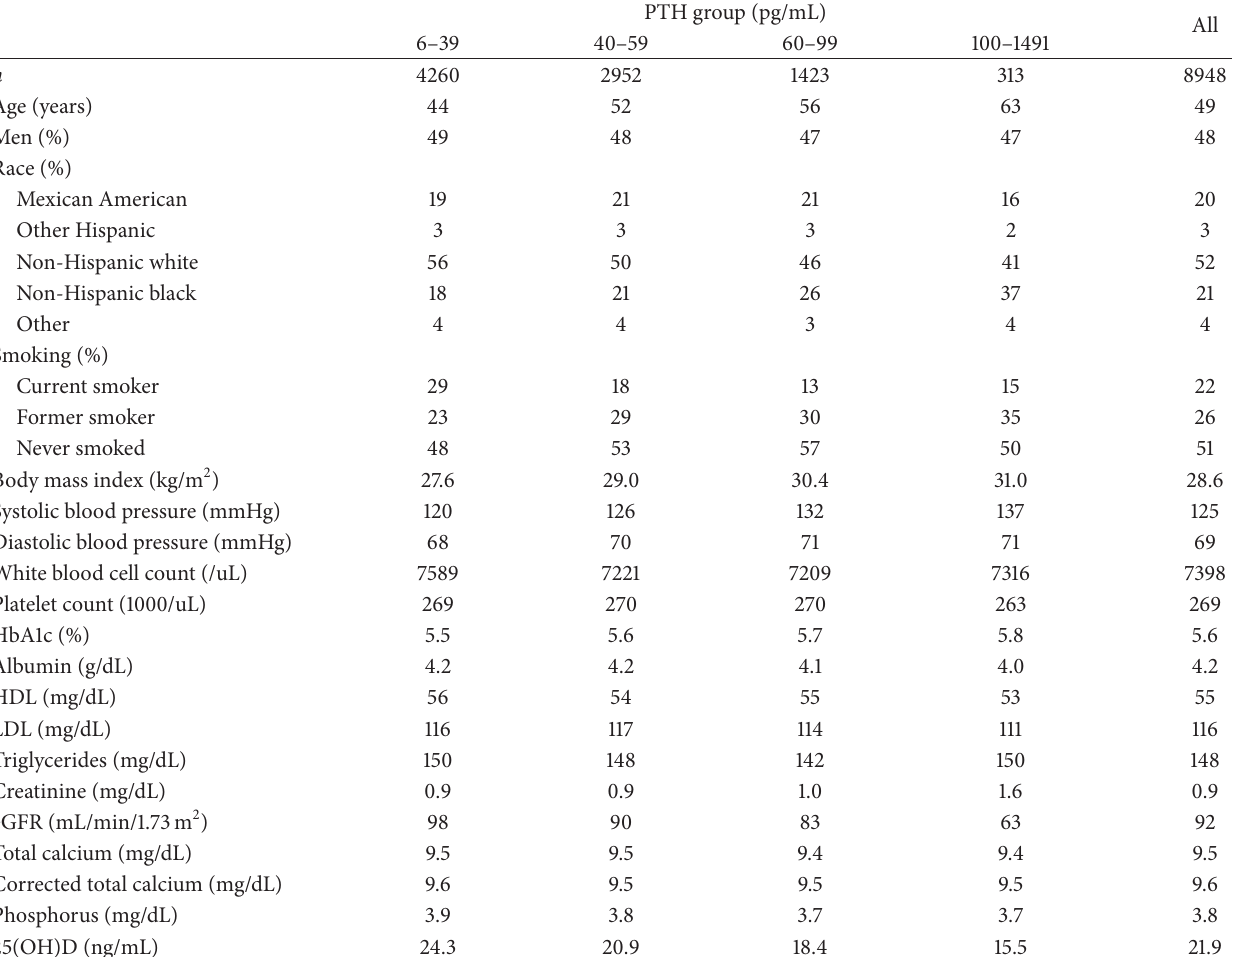
Table 1: Characteristics according to parathyroid hormone (PTH) categories among the United States adults aged at least 20 years,